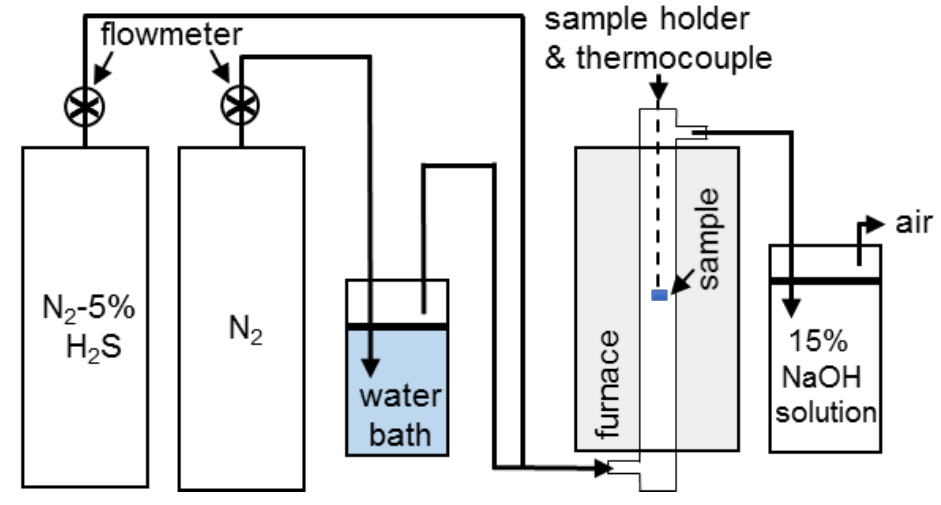
Figure 1. Corrosion testing apparatus.